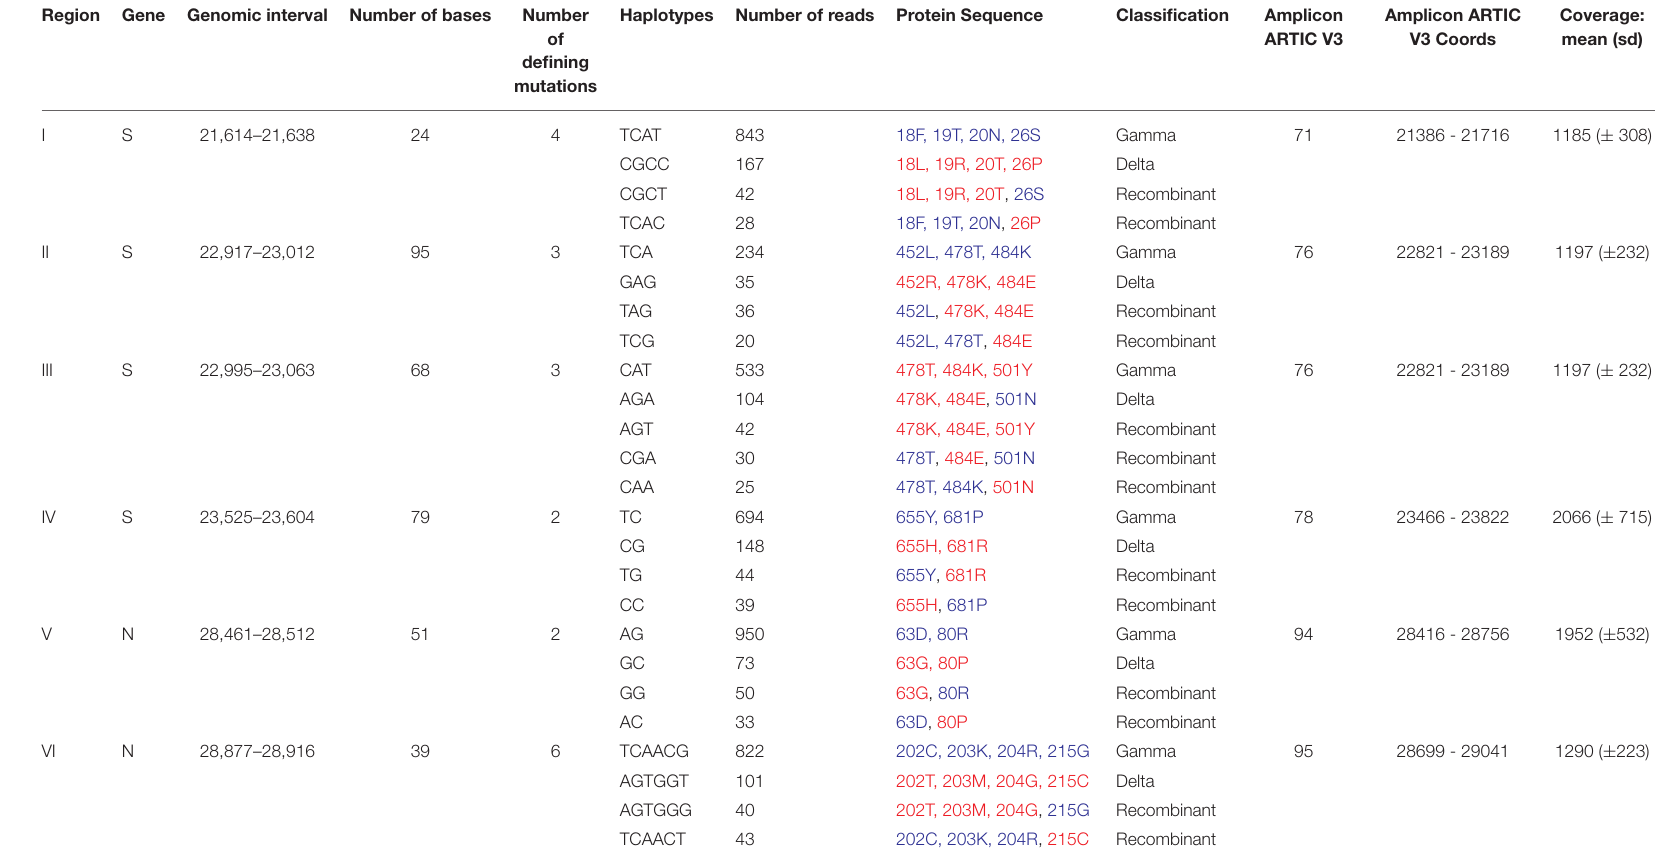
TABLE 1 | Evidence of emergence of recombinant haplotypes within a sample coinfected by Gamma and Delta variants with the mutations characteristic of Gamma and Delta are highlighted in blue and red, respectively. Region Gene Genomic interval Number of bases Haplotypes Number of reads Protein